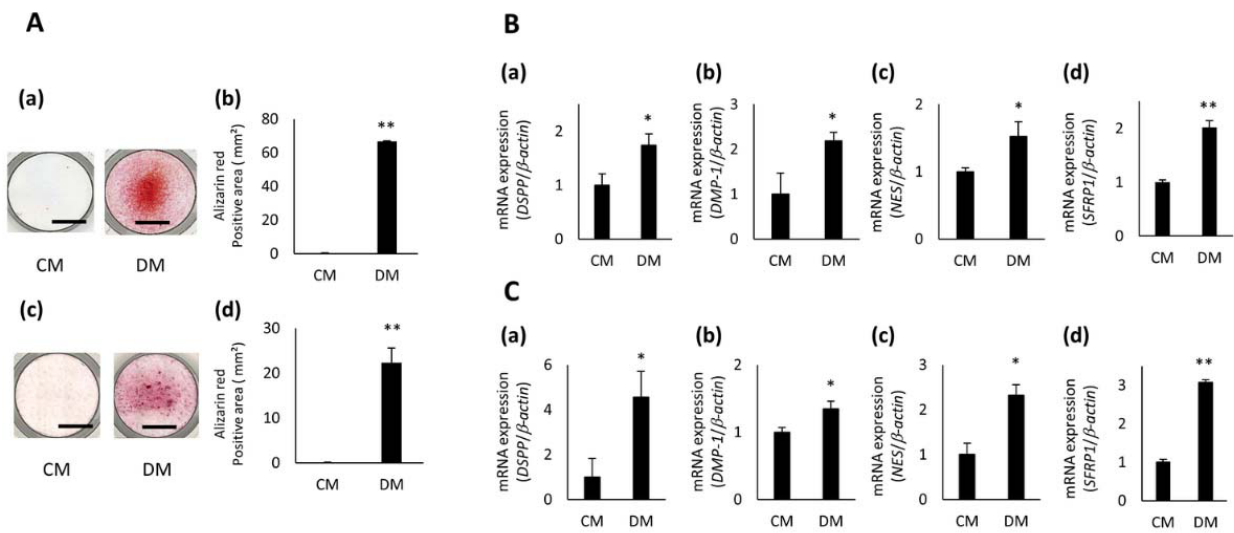
Figure 2. Gene expression of SFRP1 during odontoblastic differentiation of hDPCs. ( A ) Odontoblastic differentiation of hDPC-5N and -5I. Alizarin Red S staining images of hDPC-5N ( a ) and -5I ( c ) cultured in 10% FBS/ α -MEM (control medium; CM) or CM with 2 mM CaCl 2 (odontoblastic differentiation medium; DM) for 5 days. Experiments were performed in quadruplet. Representative data are shown. The Alizarin Red S-positive area of hDPC-5N ( b ) and -5I ( d ) cultured in CM or DM for 5 days. Gene expression of odontoblast related-markers, DSPP ( a ), DMP1 ( b ), NES ( c ), and SFRP1 ( d ) in hDPC-5N ( B ) and -5I ( C ) cultured in CM or DM for 3 days. Data are shown as the mean ± standard deviation ( n = 3). * p < 0.05, ** p < 0.01. Scale bars = 5 mm. DSPP, dentin sialophosphoprotein; DMP1, dentin matrix acidic phosphoprotein 1; NES, Nestin.